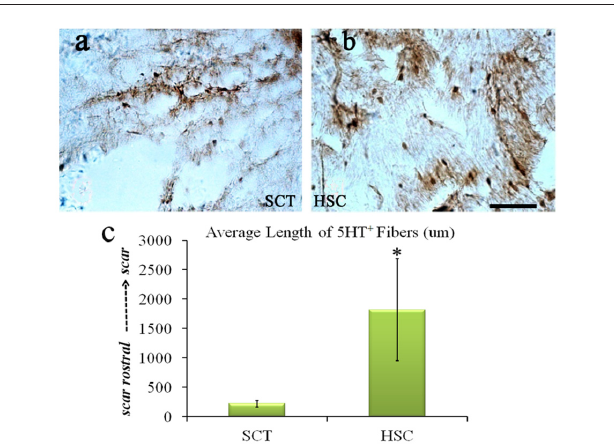
FIGURE 10 | HSC transplantation enhanced the regeneration of 5-HT fibers. After SCT, 5-HT fiber exhibited weak regeneration capacity (A) , while HSC transplantation largely increased the number of 5-HT positive fibers (B) , the length is near 2 cm (C) . Data are presented as the mean ± SD ( n = 7). Student’s t test was used to analyze the data. ∗ P < 0.05 vs. SCT. Bar = 50 µ m.